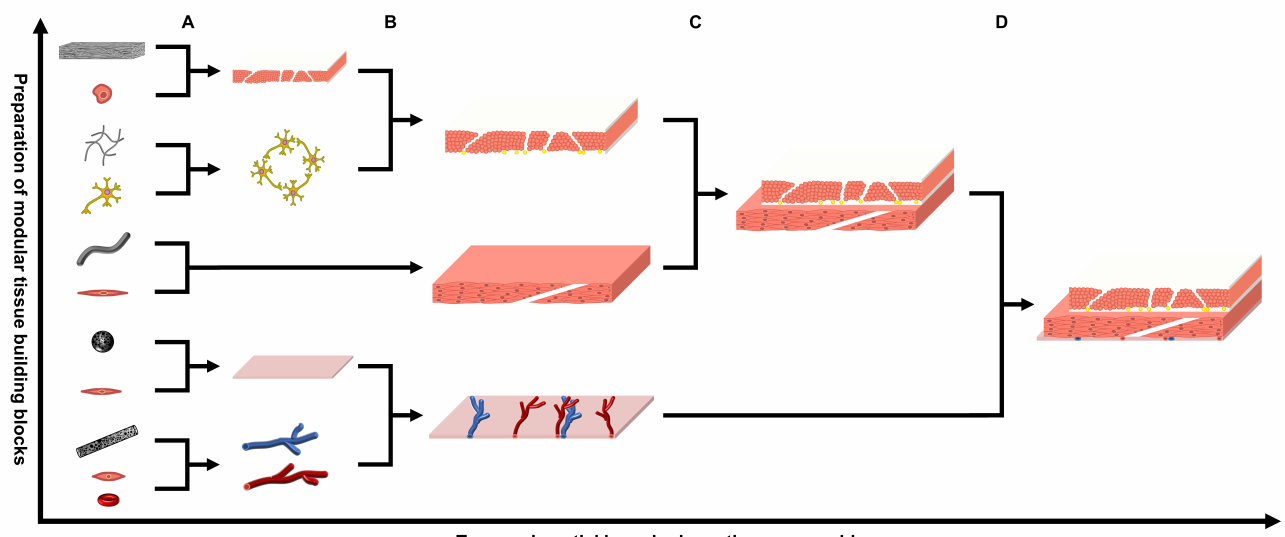
Figure 2. The gradual temporal–spatial layer-by-layer tissue assembly of functional tissues/organs via the bottom–up developmental engineering strategy. Firstly, ( A ) multiple modular tissue building blocks are prepared separately using different types of cells and their corresponding modular scaffolds with varying sizes and morphologies; ( B – D ) these modular tissue building blocks are gradually assembled layer-by-layer via specific temporal-spatial procedures to imitate the in vivo development processes as well as the anatomic structures of the target tissues/organs; this results in the formation of designated tissues/organs with increasing size and